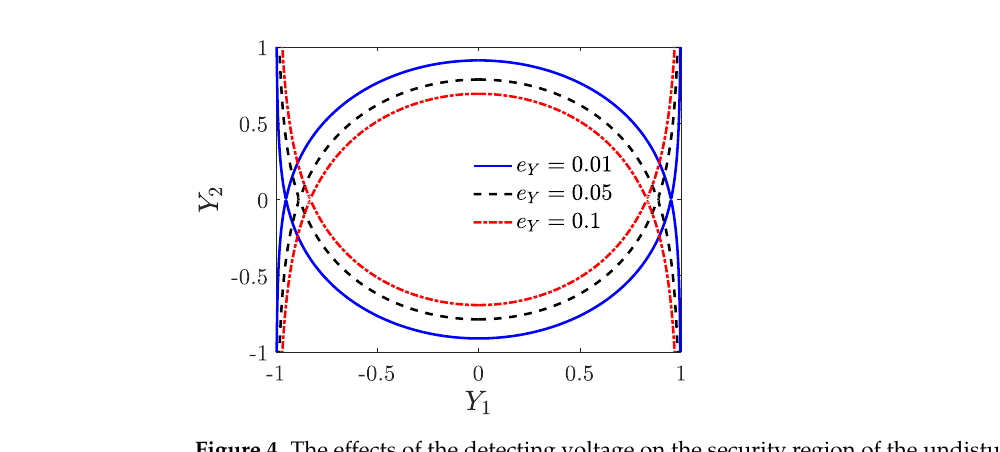
Figure 4. The effects of the detecting voltage on the security region of the undisturbed